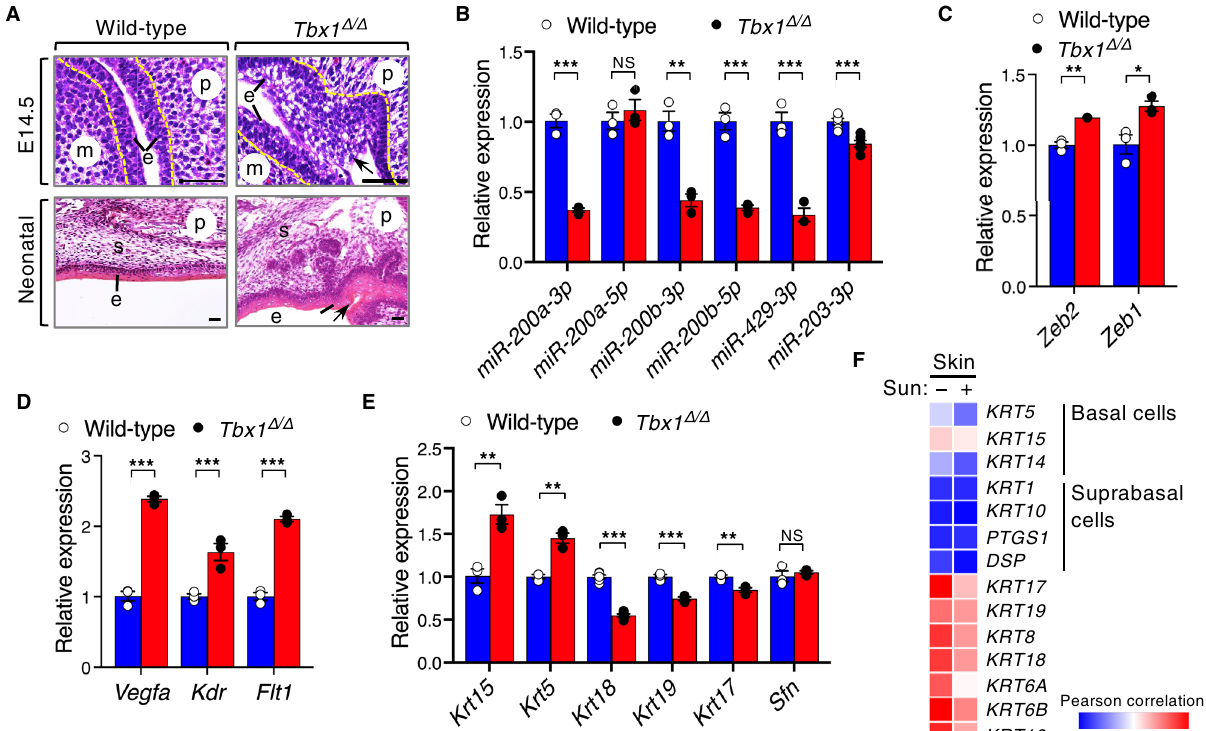
Figure 5. TBX1-mediated miRNA regulation engages epithelial differentiation in vivo. ( A ) Hematoxylin and eosin staining of the palate from wild-type and Tbx1 Δ/Δ embryos at the indicated age. Irregularities in the shape and multiple layers of the epithelium are evident in the Tbx1 Δ/Δ embryos (arrows). The broken yellow line traces the basal lamina. m, mandible; p, palatal shelf/palate; e, epithelium; s, stroma. Scale bars, 25 µm. ( B ) qPCR analysis of miRNAs in wild-type and Tbx1 Δ/Δ palatal shelves ( n = 8 per genotype) at E13.5. Expression was normalized to that of U6 and compared with that in wild-type littermates ( n = 6). ( C ) qPCR analysis of Zeb2 and Zeb1 expression in wild-type and Tbx1 Δ/Δ palatal shelves ( n = 8 per genotype) at E13.5. Expression was normalized to that of Actb and compared with that in wild-type littermates ( n = 6). ( D ) qPCR analysis of Vegfa , Kdr, and Flt1 expression in wild-type and Tbx1 Δ/Δ palatal shelves ( n = 8 per genotype) at E13.5 ( n = 6). ( E ) qPCR analysis of the expression of epithelial markers in wild type and Tbx1 Δ/Δ palatal shelves ( n = 8 per genotype) at E13.5 ( n = 3). ( F ) Heat map representing the pairwise correlation coefficients of the expression of TBX1 and epithelial differentiation markers 51 in the skin: sun-exposed (+ ; lower leg, n = 701) and unexposed (− ; suprapubic, n = 604). Pearson correlation coefficients ( r ) were calculated according to the color scale. Dark red denotes high positive correlation ( r = 0.5), dark blue denotes high negative correlation ( r = − 0.5), and white denotes a lack of correlation ( r = 0). The statistical source data are provided in Supplementary data, Figs S9–S11. For ( B-E ), the results are presented as mean ± s.e.m.; * P ≤ 0.05, ** P ≤ 0.01, *** P ≤ 0.001; NS, not significant; unpaired two-tailed Student’s t